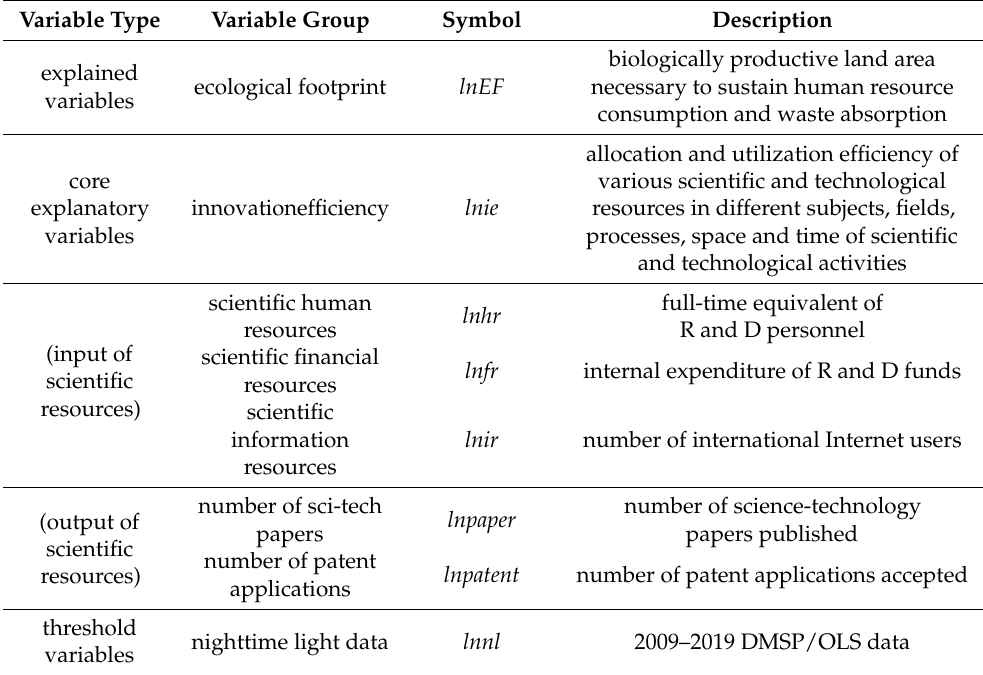
Table 1. Selection and description of